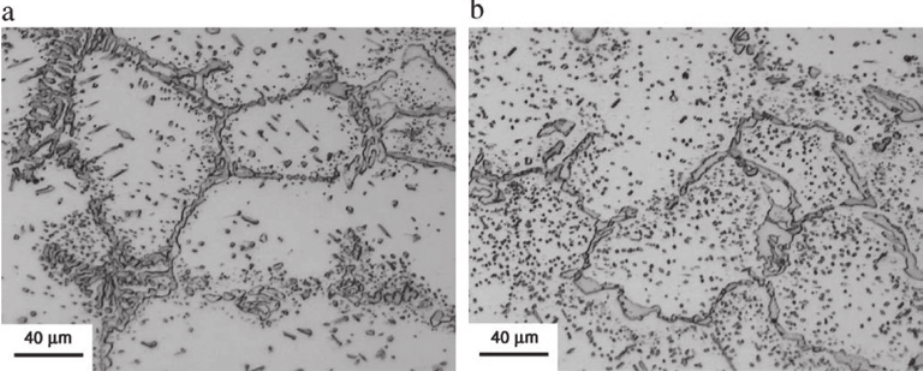
Fig. 4: Light optical micrographs of both alloys in the aged condition, (a) alloy HP-Nb; (b) alloy HP-NbTi [5].